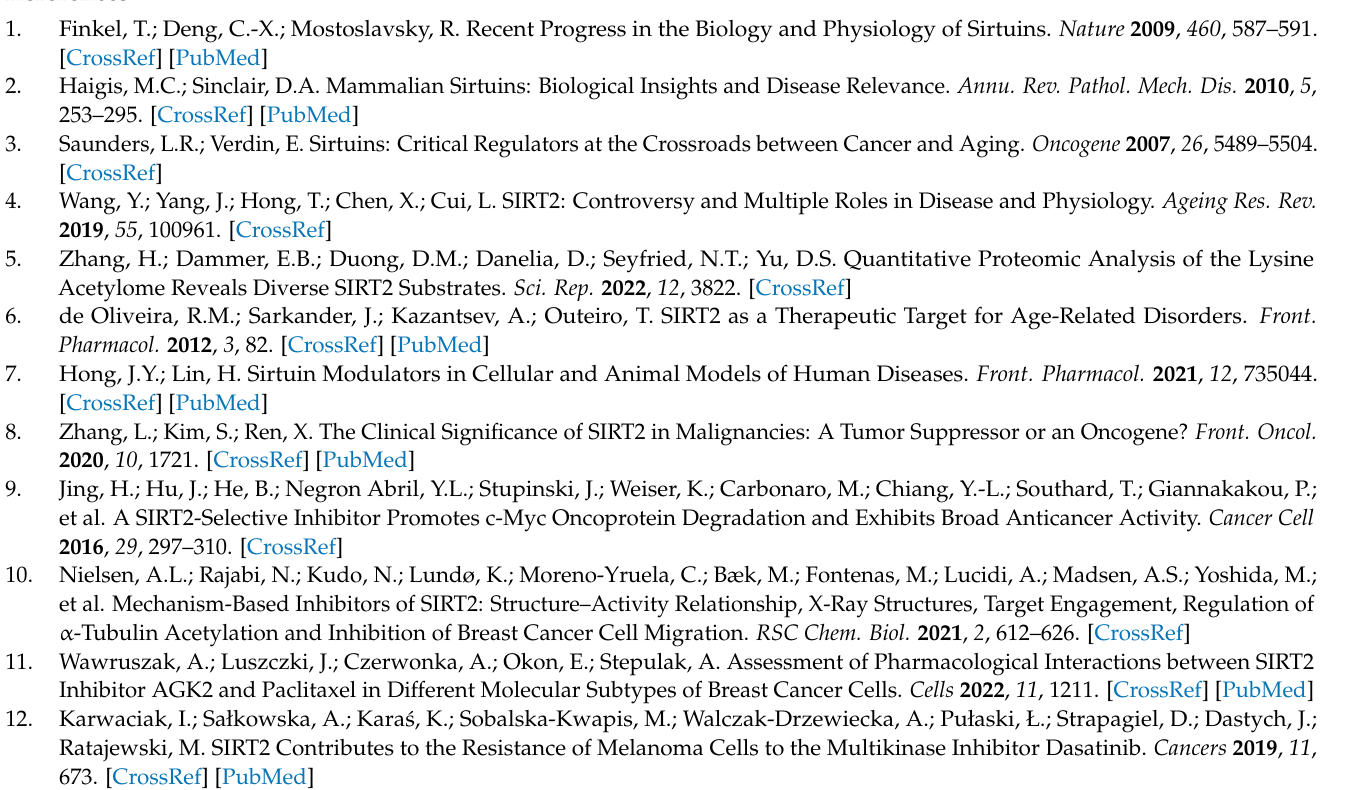
Table S10: The predictive performance parameters of the multiclass SIRT2/3 models on the decoy dataset; Table S11: Utility SIRT2i_Predictor for the processing of the previously published structure- based virtual-screening results; Table S12: Results of in vitro evaluation of the in-house compounds; Note S1: Internal-validation parameters; Note S2: Supplementary